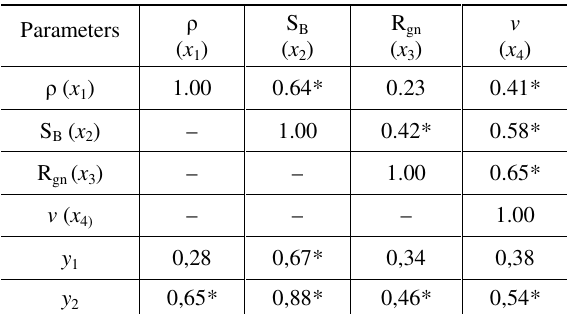
Table 4. Average values of physical and mechanical parameters No. of batch of samples